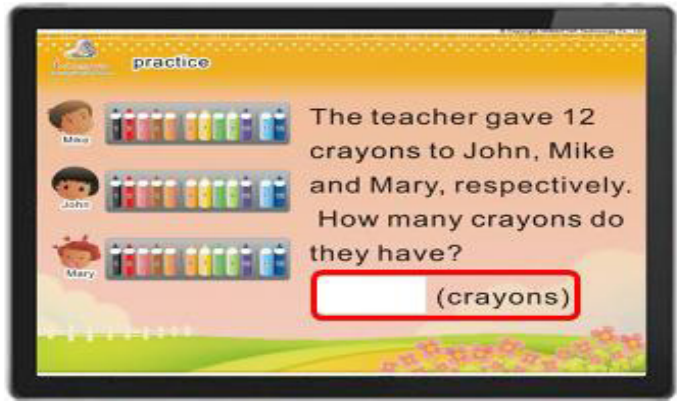
Figure 4. SimMAGIC e-book editing application layout.